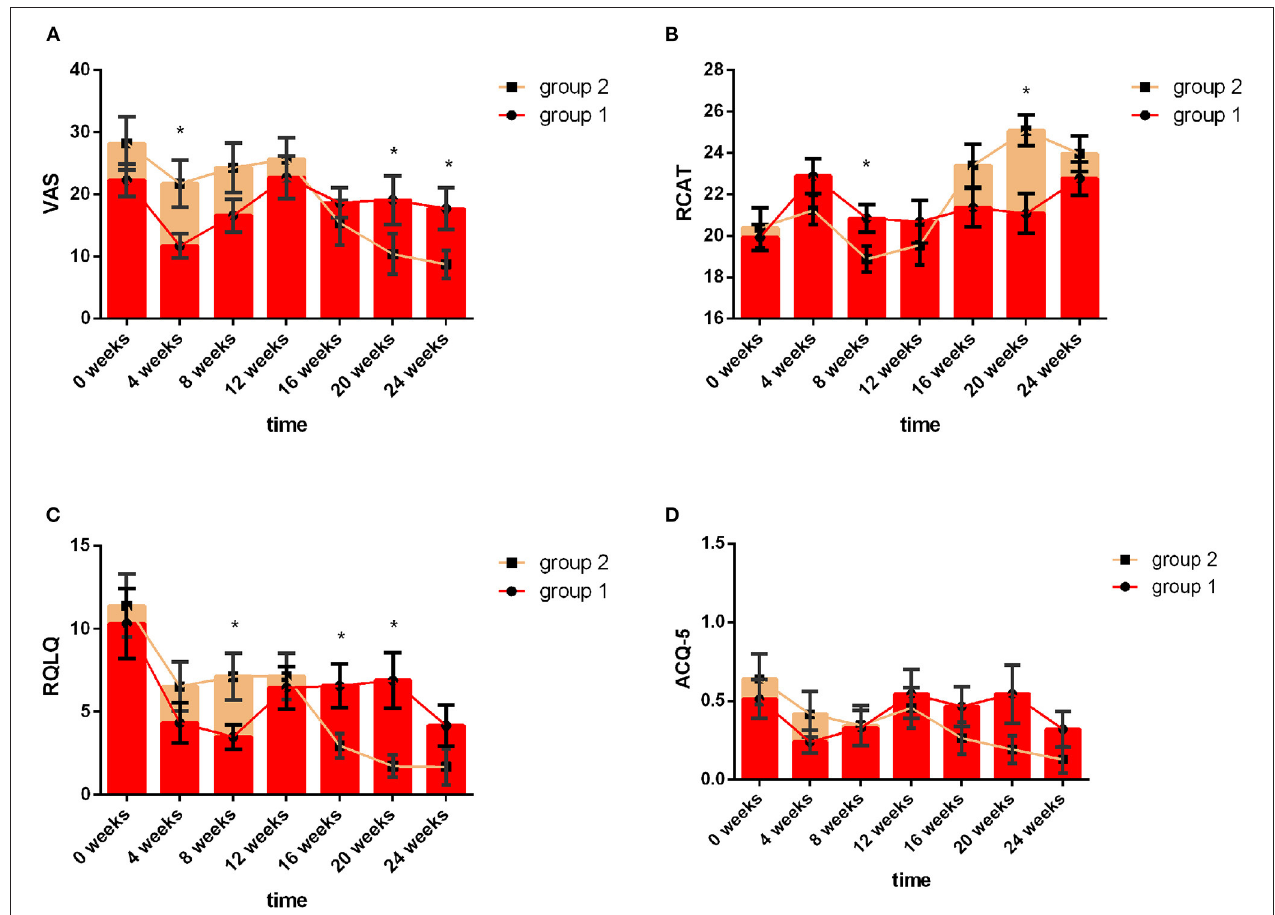
FIGURE 3 | VAS, RCAT, RQLQ and ACQ-5 scores of the two groups at different follow-up visits. The red line indicates Group 1, and the yellow line indicates Group 2. Week 0 to Week 8 refer to the first intervention phase: Group 1: acaricidal bait, Group 2: placebo; Week 8 to Week 12 refer to the washout period; Week 12 to Week 20 refer to the second intervention phase: Group 1: placebo, Group 2: acaricidal bait. Changes in the VAS (A) , RCAT (B) , RQLQ (C) , and ACQ-5 (D) scores between the acaricidal bait and placebo groups at the same time points. Bars indicate the mean values, and brackets represent the standard error. * P < 0.05 .